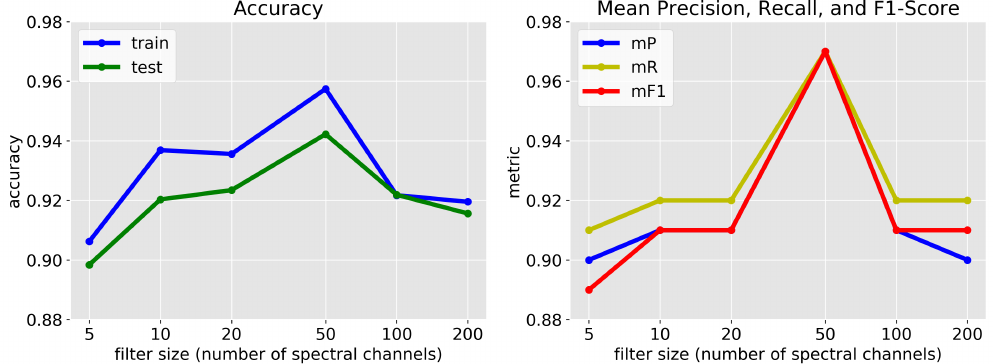
Figure 5. Accuracy of training and testing instances ( left ), and weighted average precision, recall, and F 1 Measure ( right ) of testing instances from the CNN model trained and tested on Scene 1-a with filters of different kernel sizes in the two convolutional layers. Maximum performance is obtained from kernel size 50, indicating that in general, it is the spectral features of size ∼ 35 nm that optimally discriminate between classes in urban